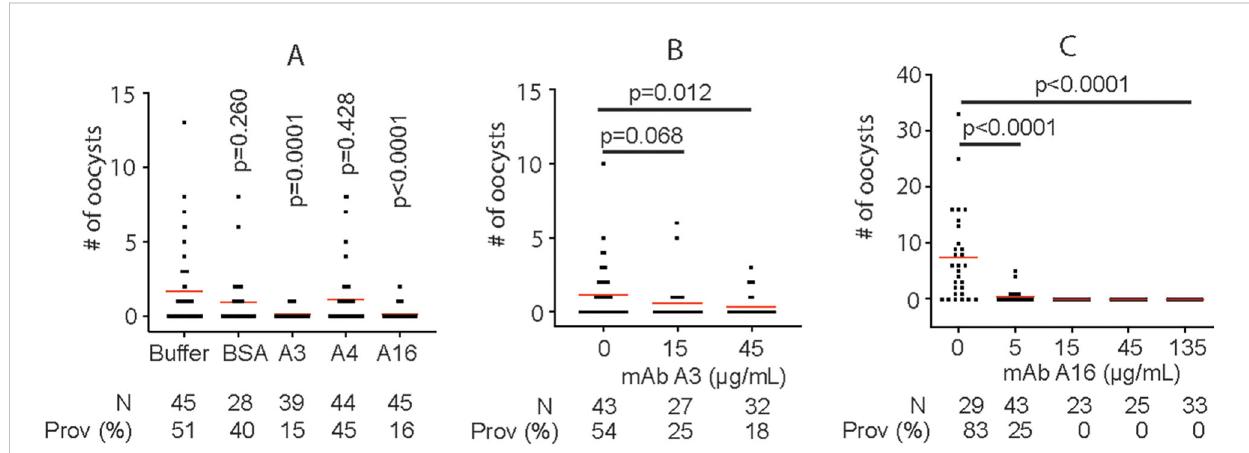
FIGURE 5 MAb A3 and A16 inhibit P. falciparum infection in An. gambiae. (A) SMFA show that A3 and A16 signi fi cantly inhibit P. falciparum transmission to mosquitoes. (B) The transmission-blocking activities of A3 depend on the antibody ’ s concentration. (C) A16 shows concentration-dependent transmission-blocking activity. Prov (%): prevalence. Each dot represents the number of oocysts from one individual mosquito. Red lines show the average number of oocysts per midgut. P values were calculated by Mann-Whitney